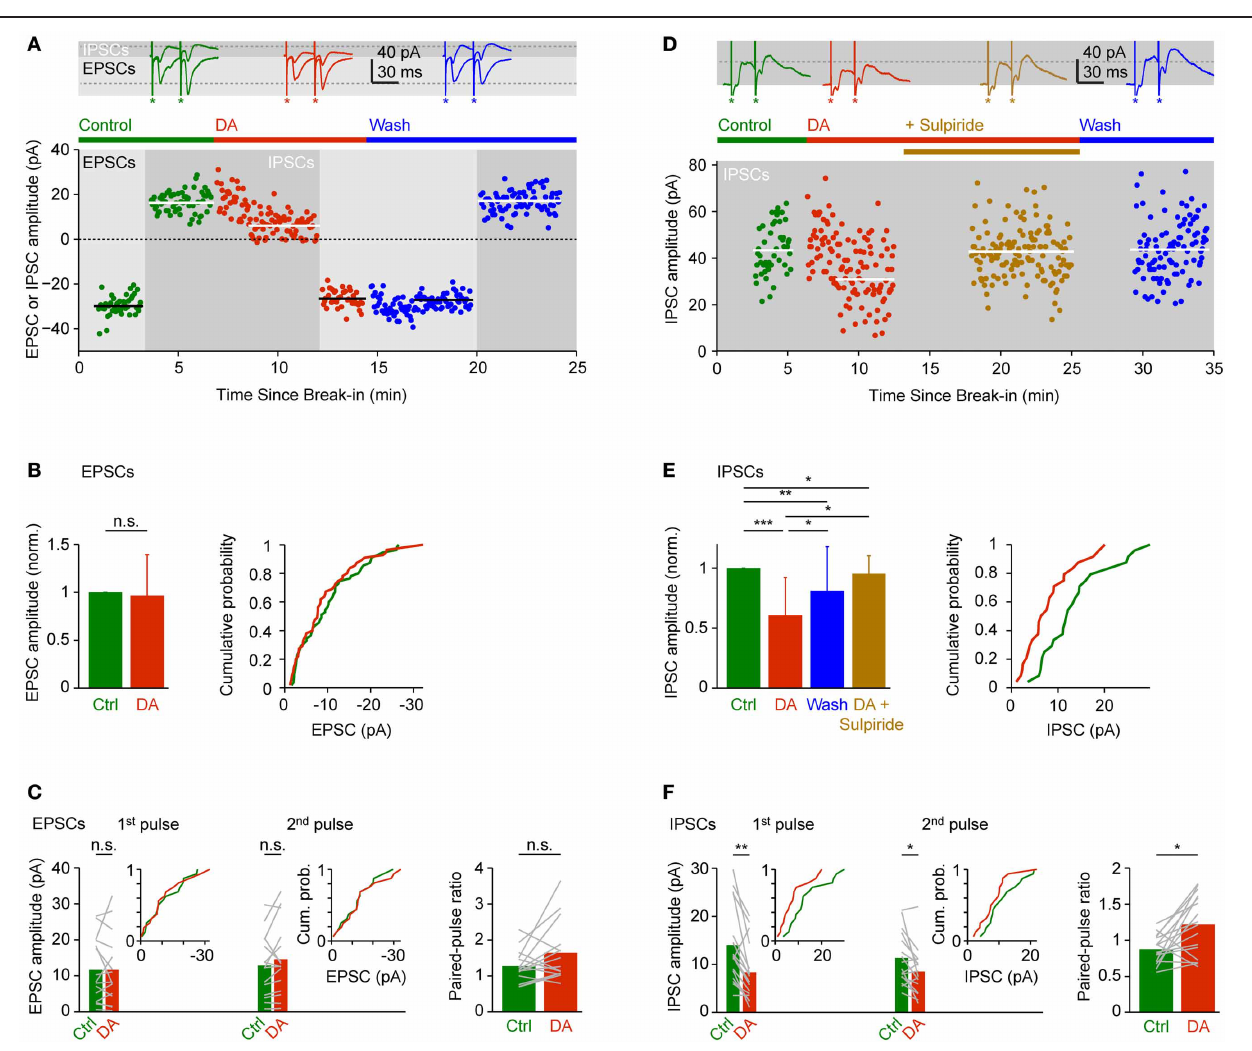
second pulse (left) and mean paired-pulse ratio (right) before and during exposure to DA ( n = 16 neurons in 9 fish, 15/16 neurons vglut2a- GFP-positive). Gray lines show changes in individual neurons. Insets show cumulative probability distributions of EPSC amplitudes. (D) Effects of DA and sulpiride on IPSCs in a different Dp neuron. In the scatter plot, current amplitude was quantified in response to the first pulse only. (E) Mean normalized IPSC amplitude ( ± SD; left) and cumulative probability distribution of IPSC amplitudes before (green) and during (red) exposure to DA. Effect of DA and washout was tested in n = 17 neurons from 10 fish (all vglut2a- GFP-positive). Effect of DA and sulpiride was tested in an additional n = 4 neurons from 4 fish (all vglut2a-GFP-positive). If currents were evoked by pairs of pulses, only the response amplitude evoked by the first pulse was quantified. (F) Mean IPSC amplitude evoked by the first and second pulse (left) and mean paired-pulse ratio (right) before and during exposure to DA ( n = 16 neurons in 9 fish, 15/16 vglut2a-GFP-positive). Insets show cumulative probability distributions of IPSC amplitudes. ∗ P < 0 . 05; ∗∗ P < 0 . 01; ∗∗∗ P < 0 . 001; n.s., not significant.